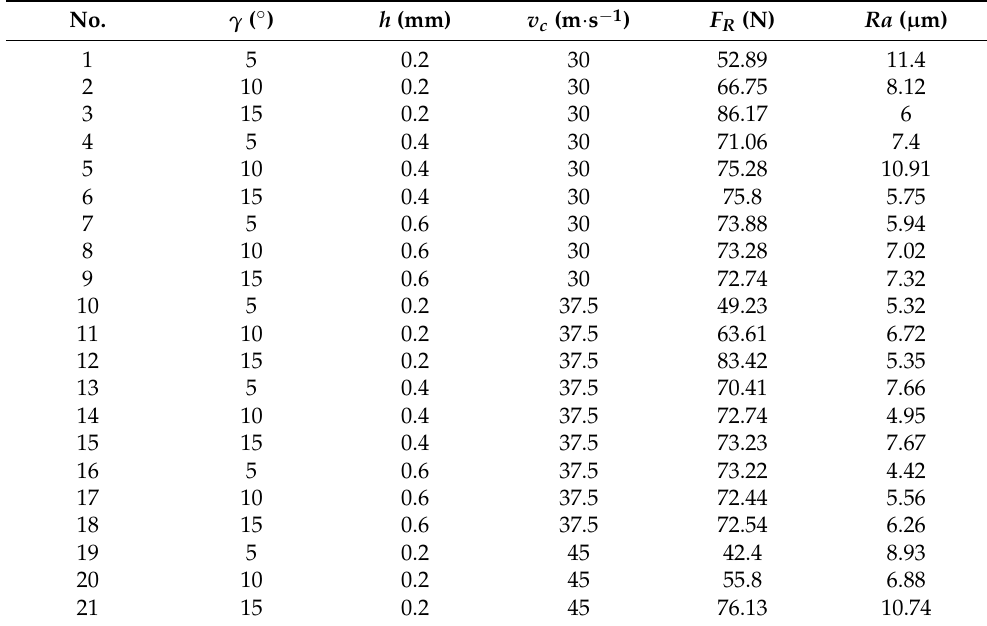
Table 4. Experimental design and